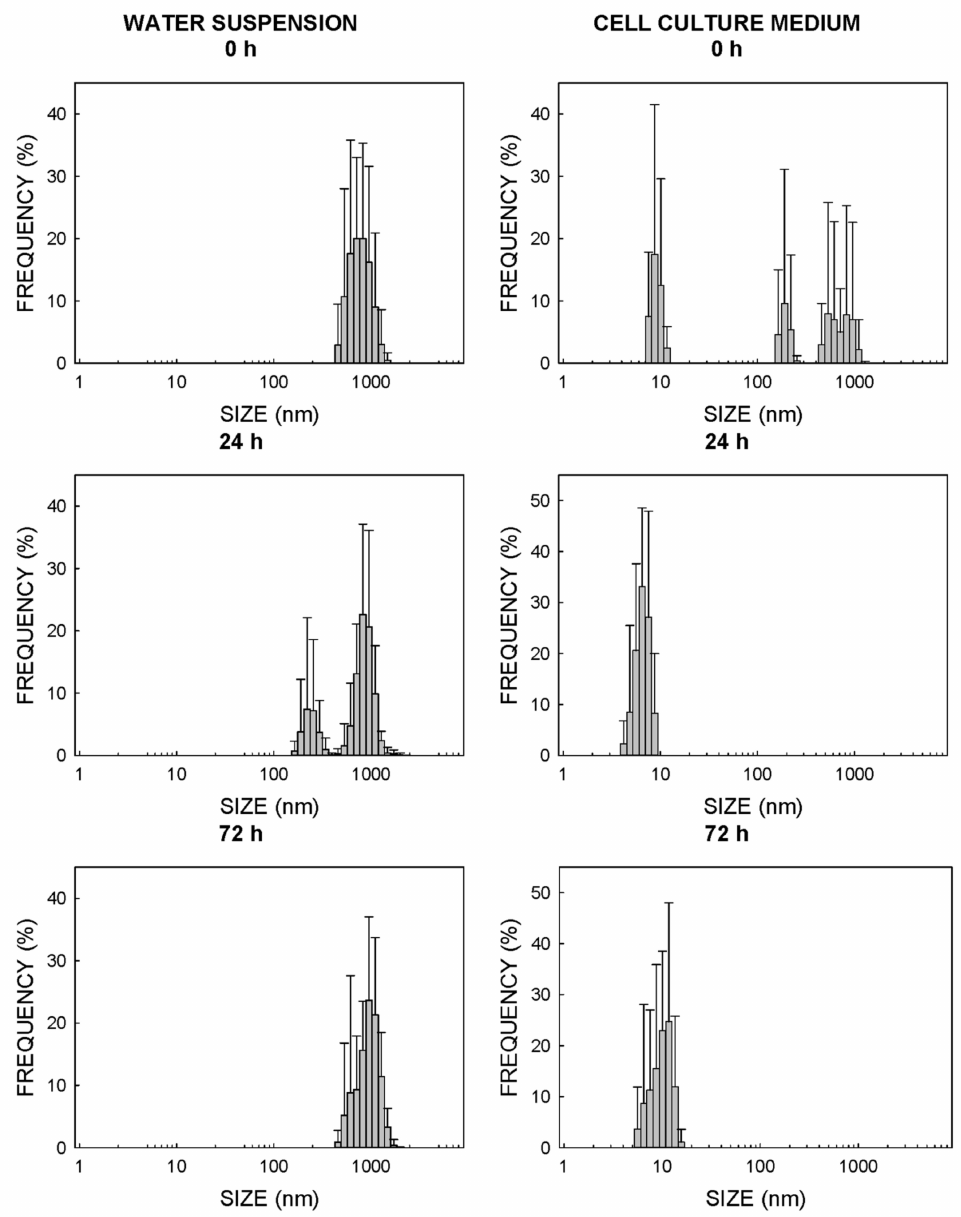
Figure 3. Analysis of the size and distribution of TiO 2 -NPs in water ( left panels ) and the cell culture medium ( right panels ). Size was determined by DLS. The cell culture medium was the the Roswell Park Memorial Institute (RPMI) cellular medium supplemented with 10%